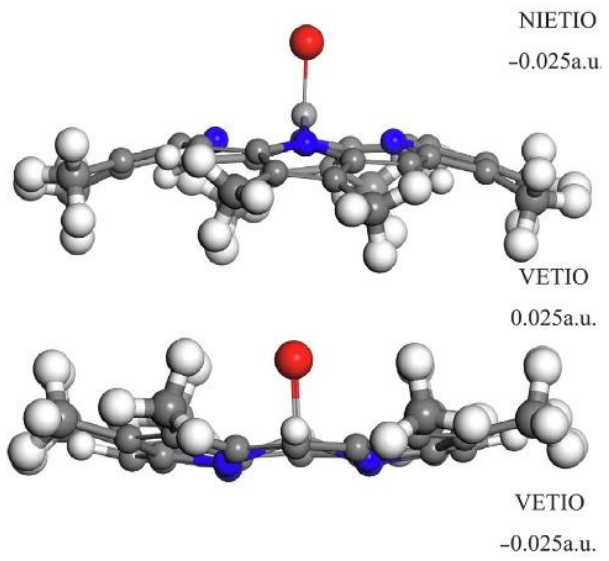
Figure 3. Molecular structures of vanadium porphyrin in the electric fields of 0.025 and 0.030 a.u. in the z direction. Reproduced with permission from [68], Copyright Elsevier, 2020.